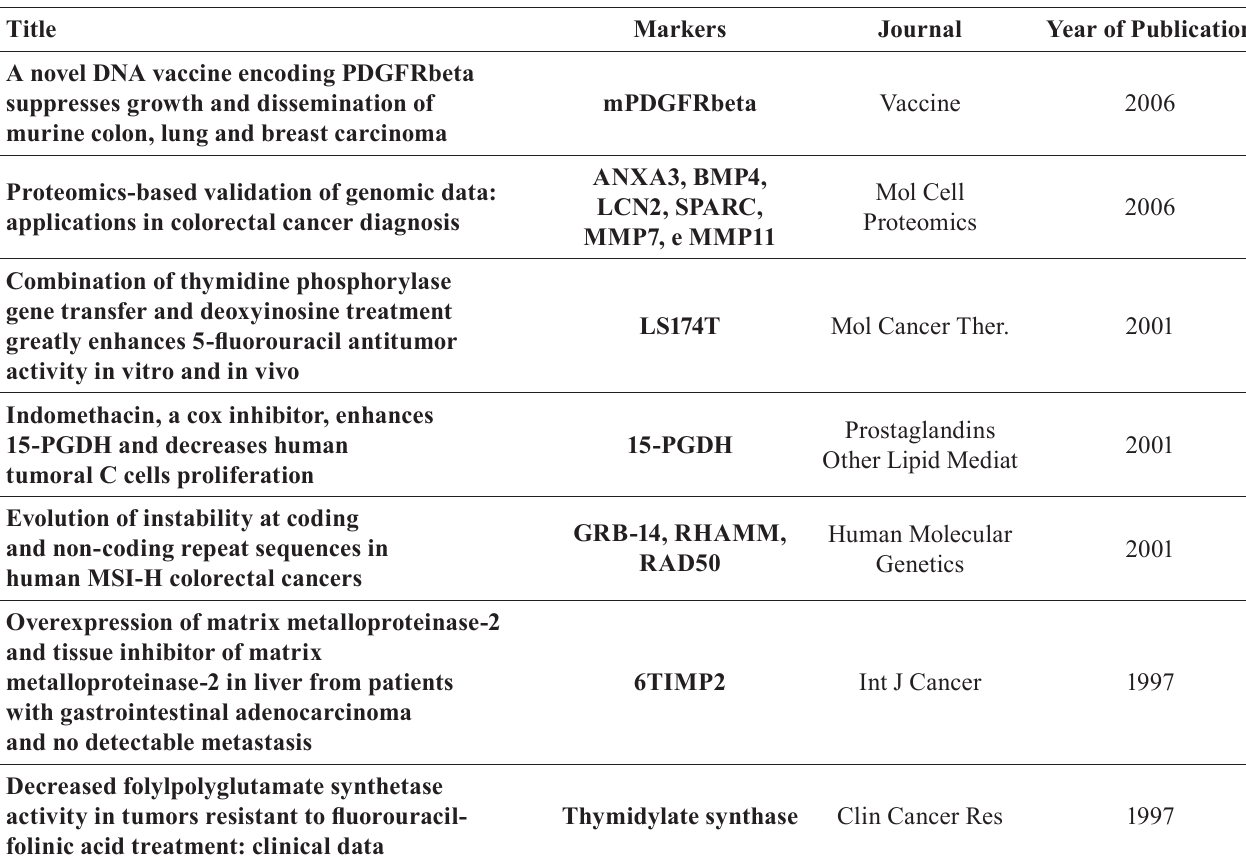
TABLE I - T umor targets of CRC identified in articles searched in PubMed, with their respective journals and year of publication